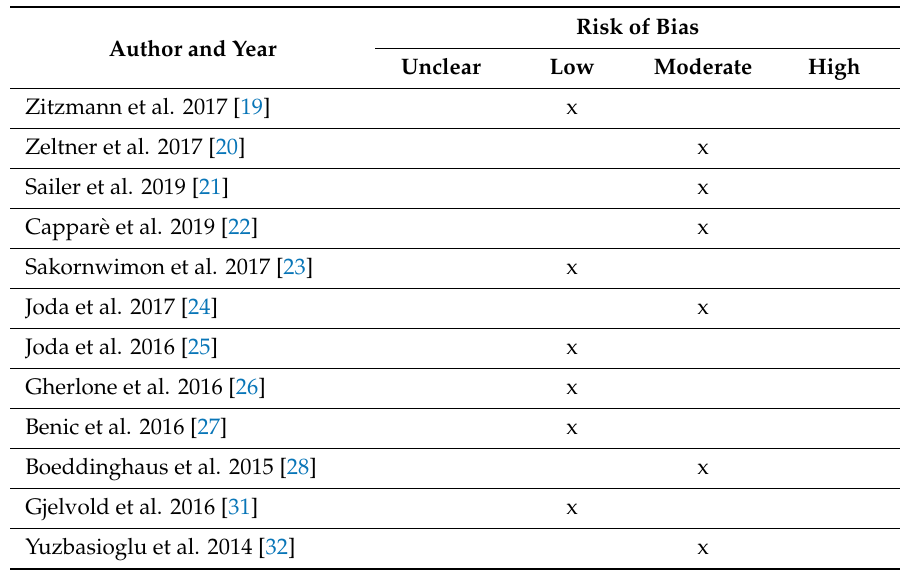
Table 1. Individual Risk of Bias